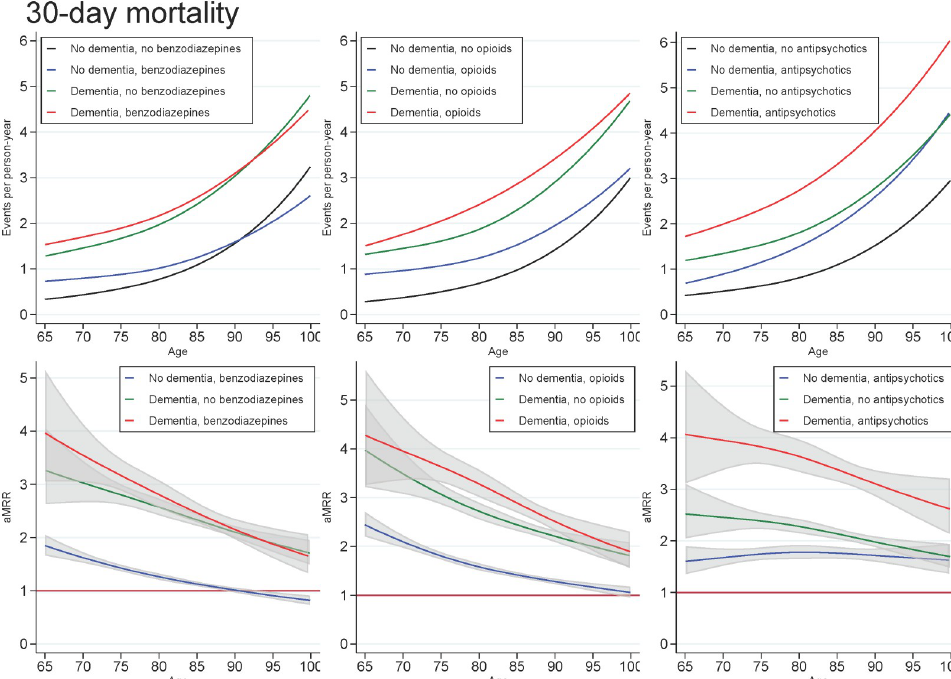
Fig 1. Unadjusted mortality rates and adjusted mortality rate ratios for patients with dementia (without medication use), patients with use of benzodiazepines, opioids or antipsychotics (without dementia), and patients with both or neither exposures, plotted as a function of age. Abbreviations: aMRR: adjusted mortality rate ratios. MRRs adjusted for sex, age, calendar period, cohabitation status, length of stay, type of pneumonia diagnosis, time since discharge, somatic comorbidities, psychiatric comorbidities, and alcohol/substance